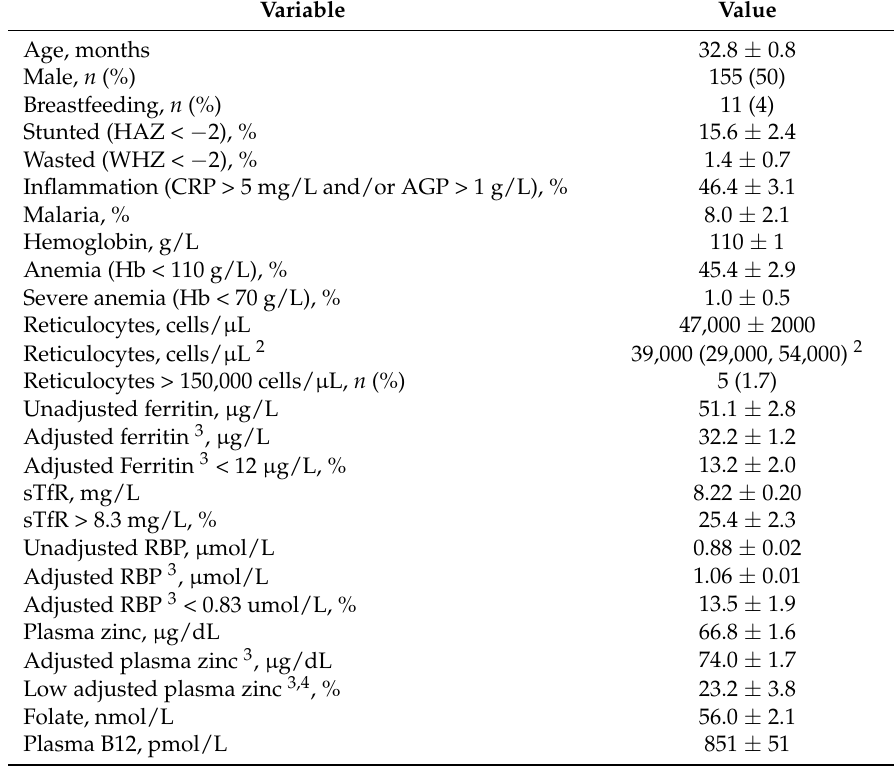
Table 1. Characteristics of children 12–59 months of age in Yaound é and Douala, Cameroon 1 .